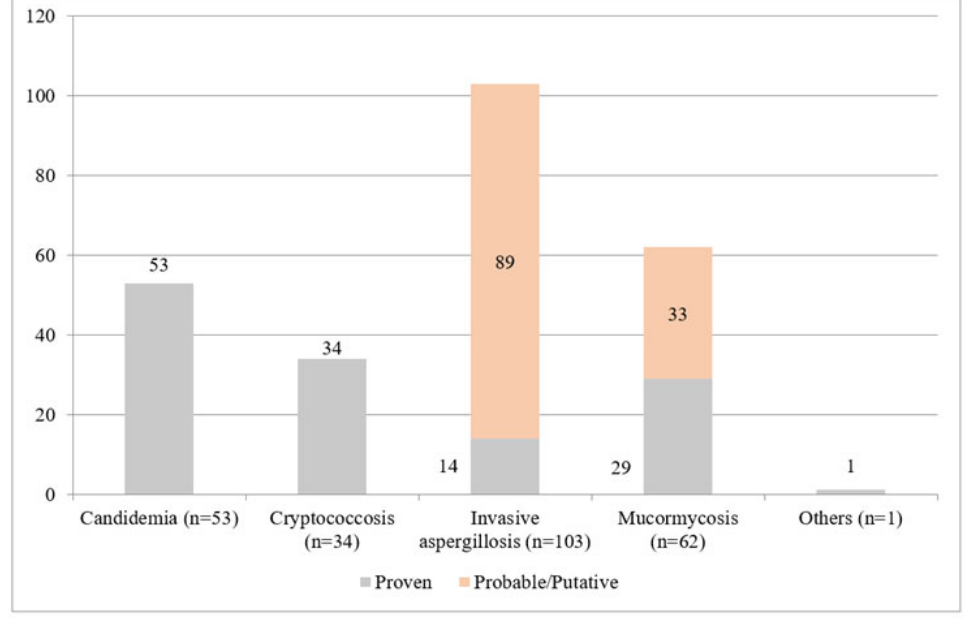
Figure 1. Cases distribution as proven and probable/putative IFI. Table 1. Site of invasive fungal infections